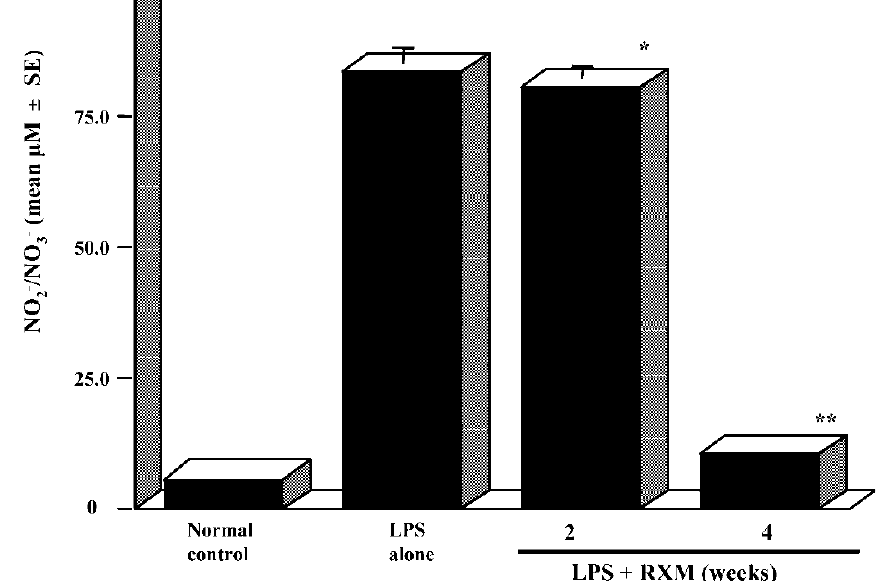
FIG. 3. Influence of RXM on NO (NO 2 (cid:1) /NO 3 (cid:1) ) generation in response to LPS injection. ICR mice were administered orally with RXM once a day for 2 and 4 weeks at a dose of 2.5 mg/kg of RXM. The mice were then injected intraperitoneally with 5.0 mg/kg of LPS, and plasma NO 2 (cid:1) /NO 3 (cid:1) levels were examined 6 h later. The data are expressed as the mean ( m M) 9 / standard error of five mice. * Not significant compared with LPS alone; ** significant compared with LPS